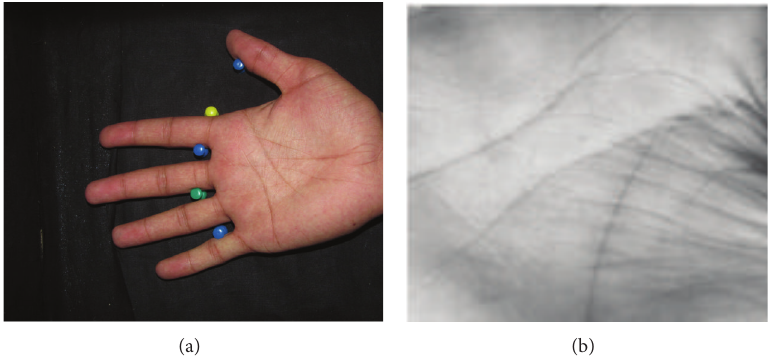
Figure 3: (a) Sample input image. (b) ROI image for COEP palmprint database.